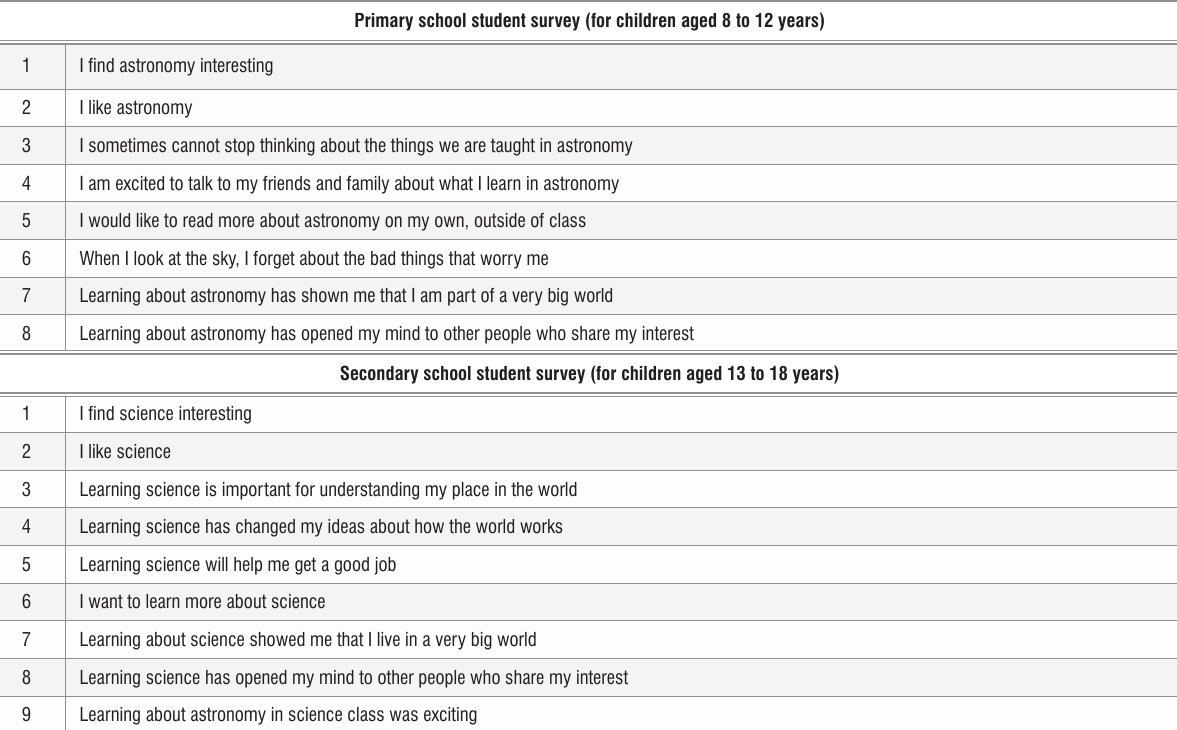
Surveys for children participating in astronomy